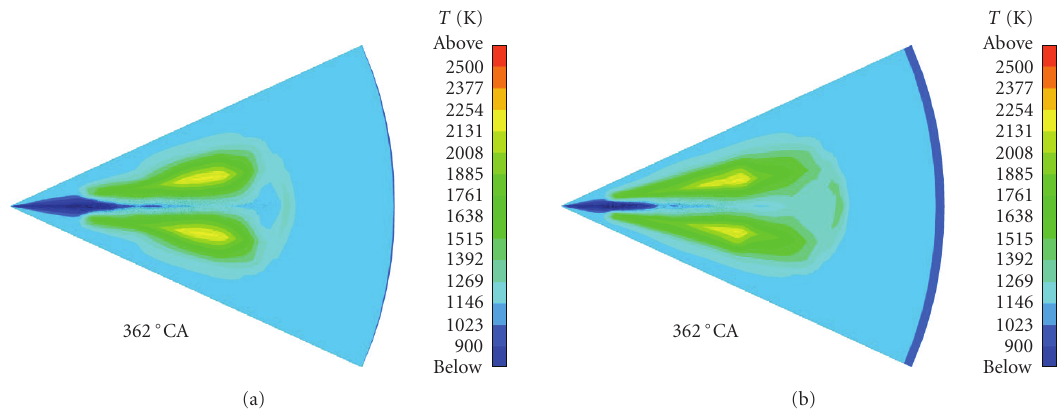
Figure 17: (a) Temperature distribution of the 25% emulsion; and (b) pure diesel fuel flame, cutplane A.